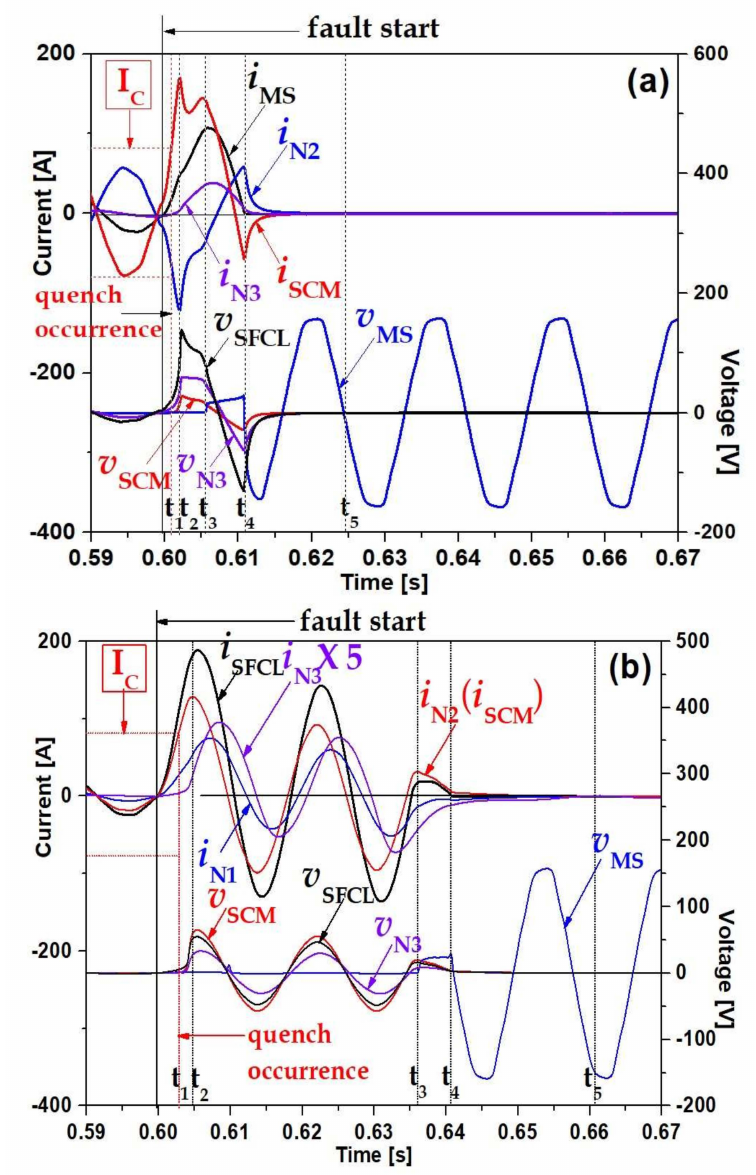
Figure 5. Fault current limiting and breaking operational sequence of the SFCLB using flux coupling with a tap changer. Current waveforms of the mechanical switch (MS) ( i SFCL = i MS ) and coils ( i N1 , i N2 , i N3 ), voltage waveforms of superconducting fault current limiter (SFCL), MS, SCM ( v SFCL , v MS , v SCM ) and coil N 3 ( v N3 ) ( a ) In the case of a series connection ( b ) In the case of a parallel